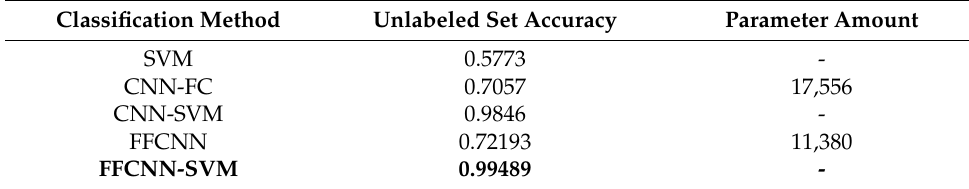
Table 8. Classification accuracy of different methods for unlabeled sample sets.